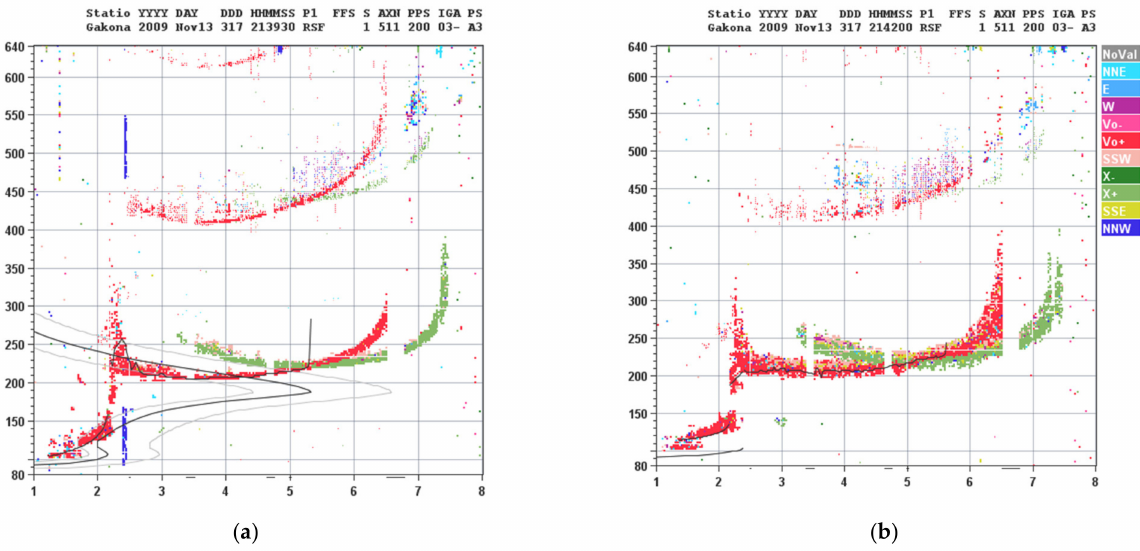
Figure 5. A pair of ionograms ( a ) without heating effect and ( b ) with heating effect; the ionogram in ( b ) was acquired at the beginning of the moment the heater turned off after the 5.75 MHz O-mode heater turned on for 2